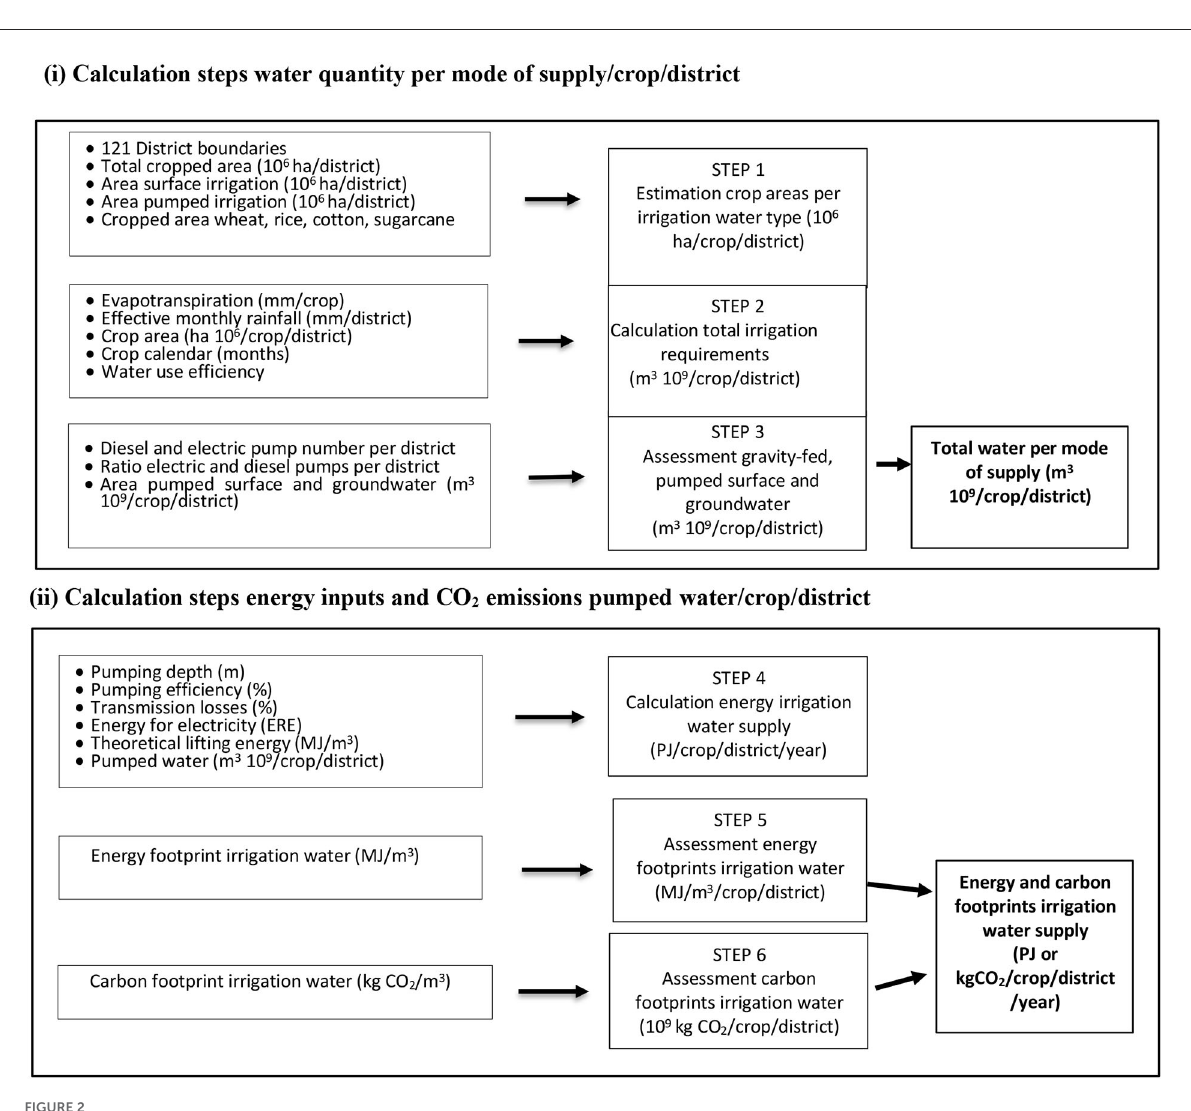
FIGURE2 Calculation steps in two clusters for the energy and carbon footprints of irrigation water supply. (i) water by mode of supply/crop/district and (ii) energy for pumping water/crop/district and related CO 2 emissions in